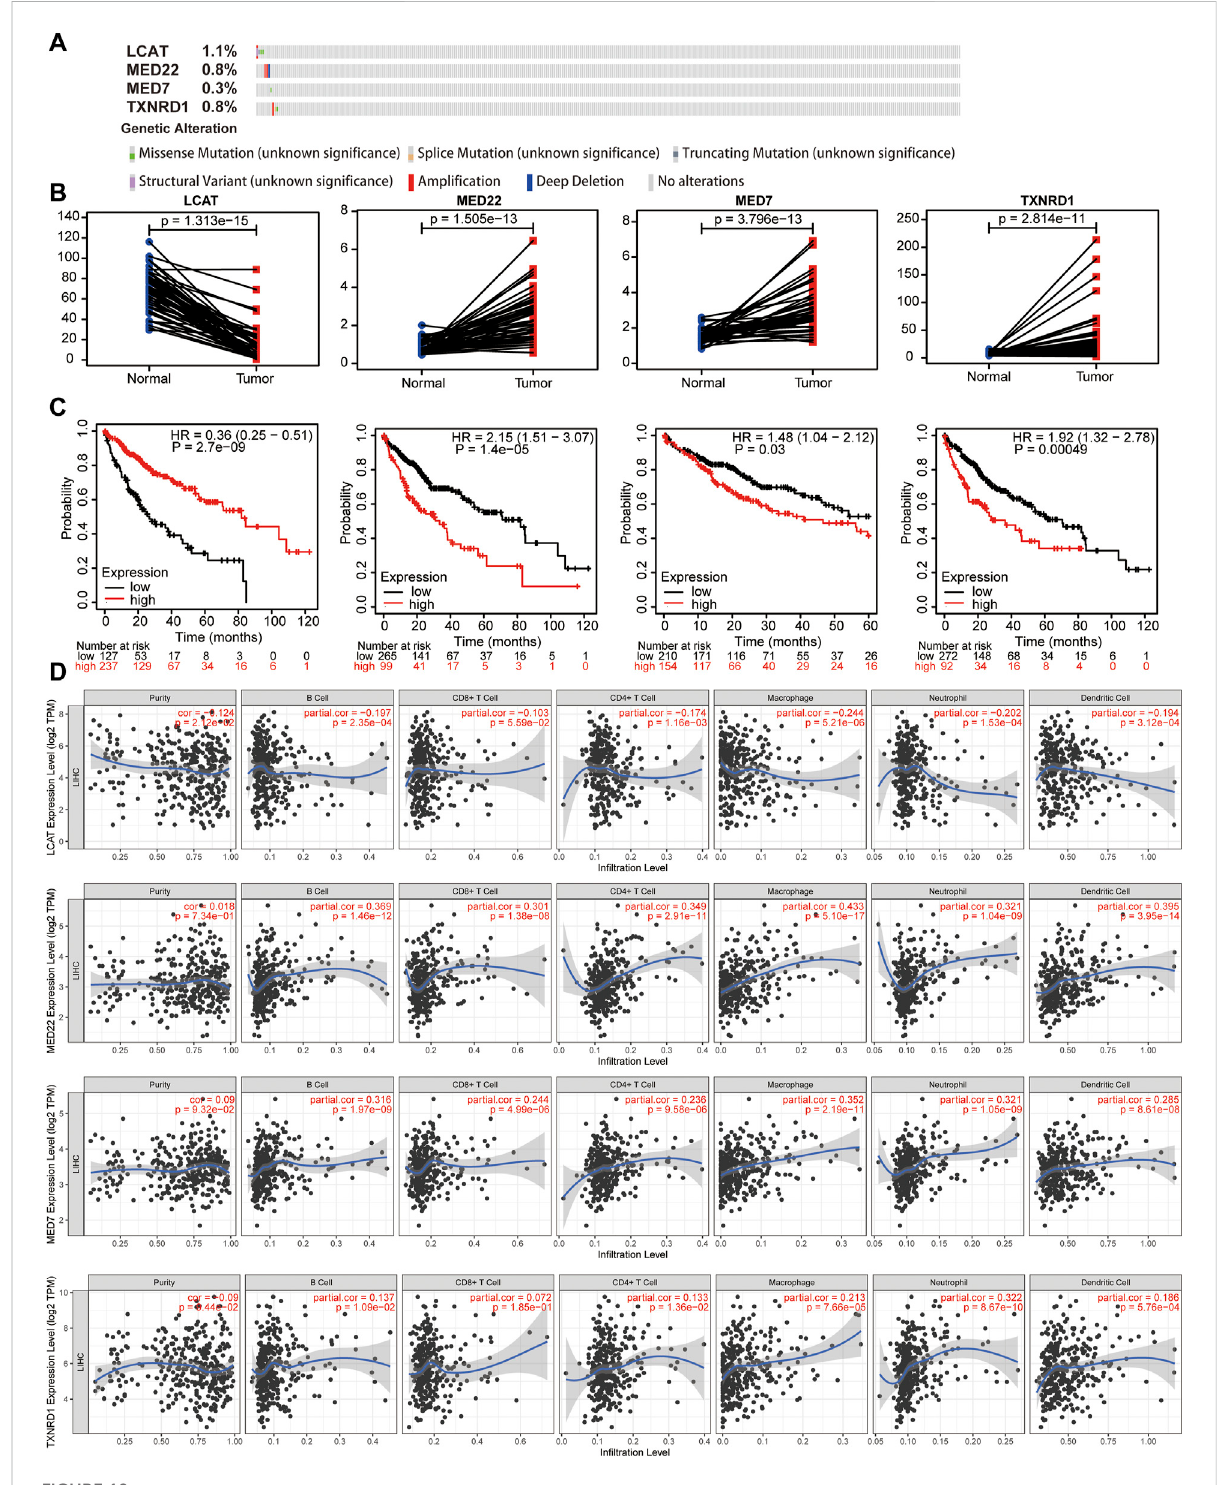
FIGURE 10 Genetic alterations, expression levels, prognosis and correlation with immune cells of the four predictive lipid metabolism-associated genes. Geneticalterations (A) ,expressionlevels (B) andsurvivaloutcomes (C) ofthe4lipidmetabolism-associatedgenes. (D) Effectsoftheexpressionlevels of four LMAGs on the immune cell in fi